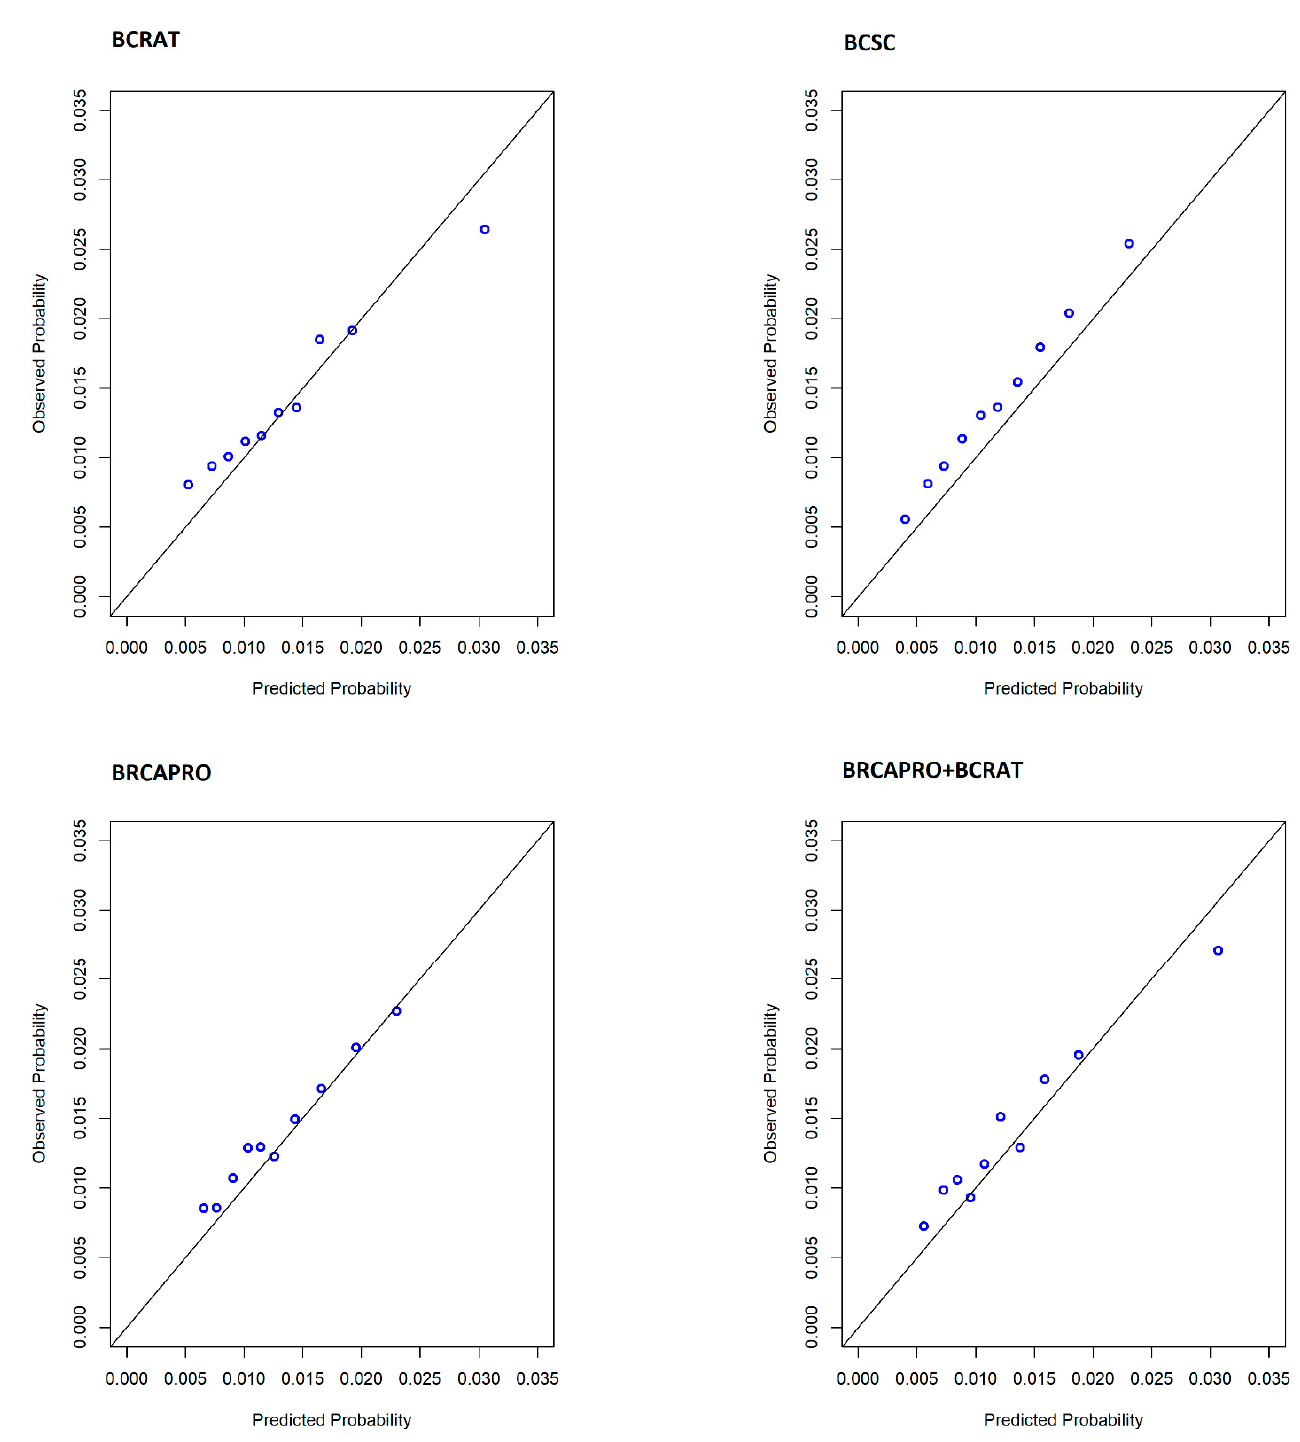
Figure 2. Calibration curves for risk prediction models.